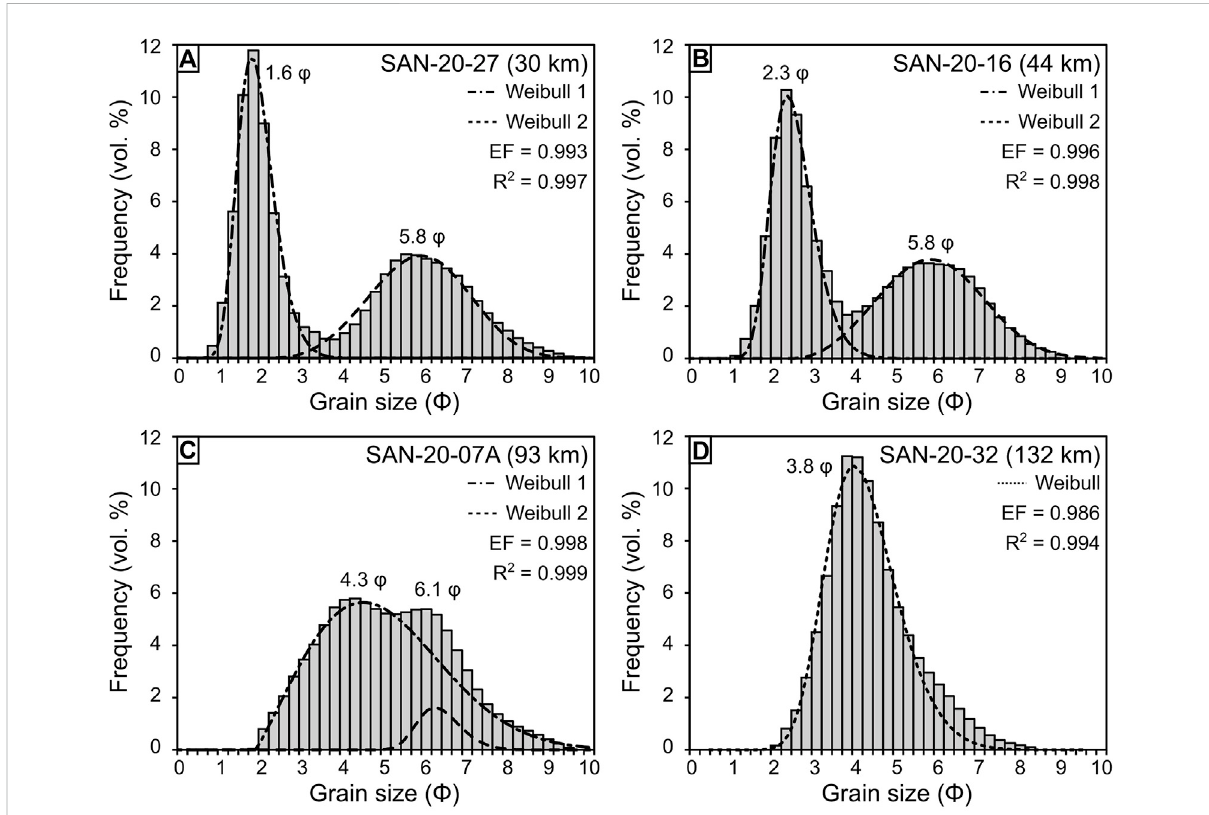
FIGURE 7 Example of grain-size distribution from the Sangay fallout with Weibull sub-populations. (A) and (B) are unimodal; (C) is bimodal in transition to unimodal; (D) is unimodal. Samples are order by distance from the volcano. EF: model ef fi ciency coef fi cient; R 2 : coef fi cient of determination.